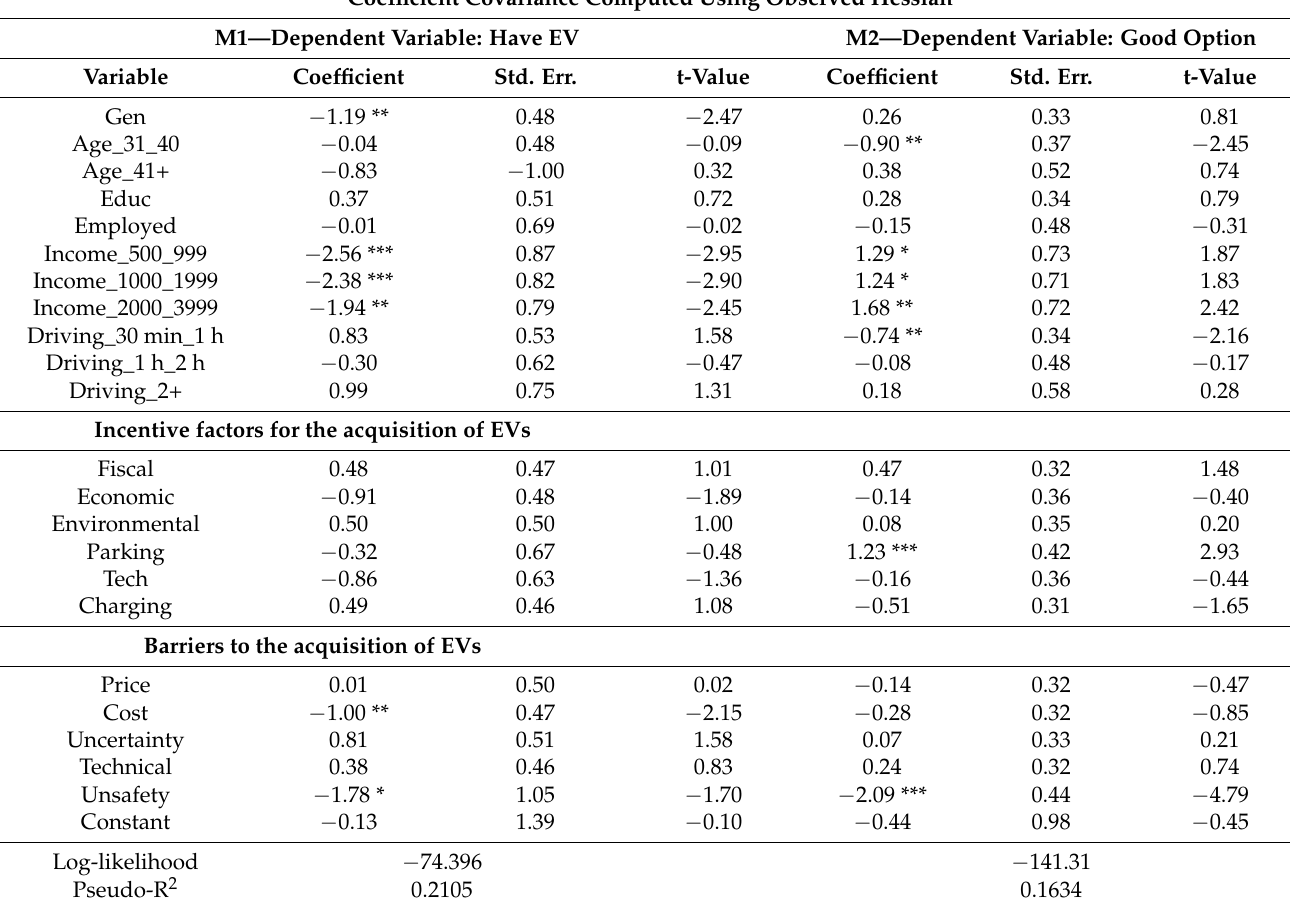
Table 6. Binary Logit Model Results for the Domestic